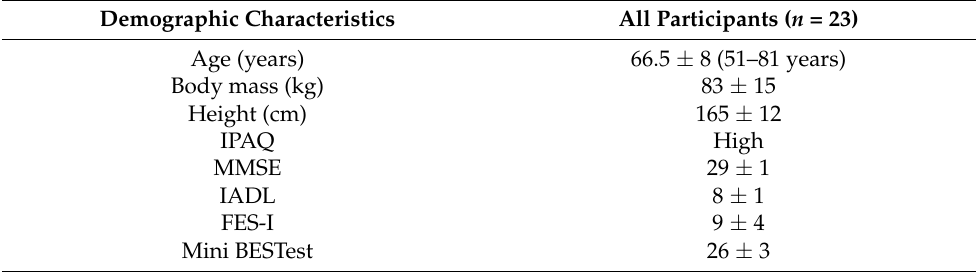
Table 1. Descriptive characteristics of participant demographics.